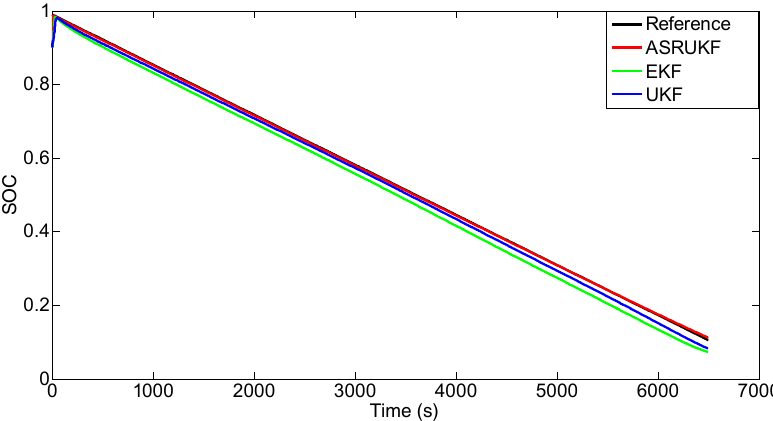
Figure 8. EKF, UKF, and ASRUKF SOC estimation results in a constant-current random discharge test.